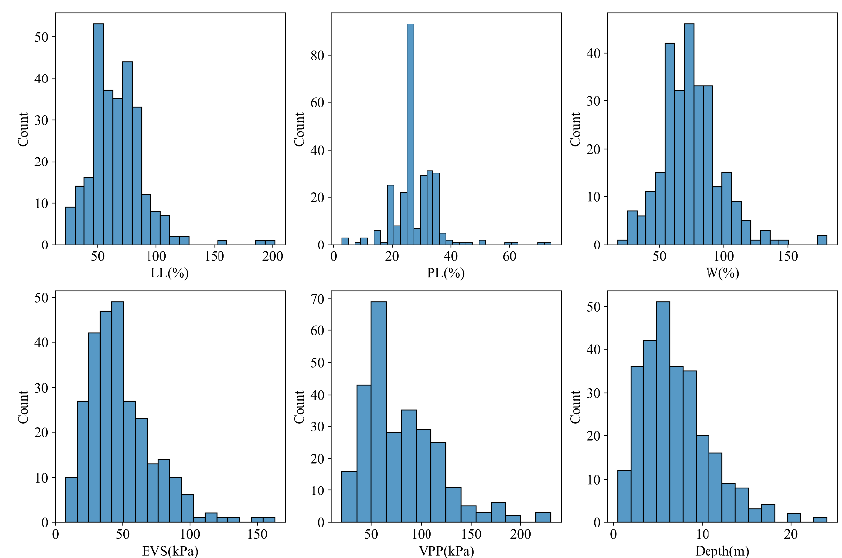
Figure 2. Distribution of input parameters. Table 1. Statistical information of clay parameters.